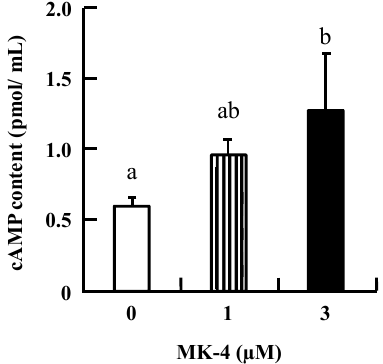
Figure 2. MK-4 regulated GSIS in mouse pancreatic islets. Isolated islets were treated with 20 µM MK-4 ( A ) or incubated time ( B ) with 2.8 mM Glc for 1 h. Data are presented as mean ± SE ( n = 5); * p < 0.05.